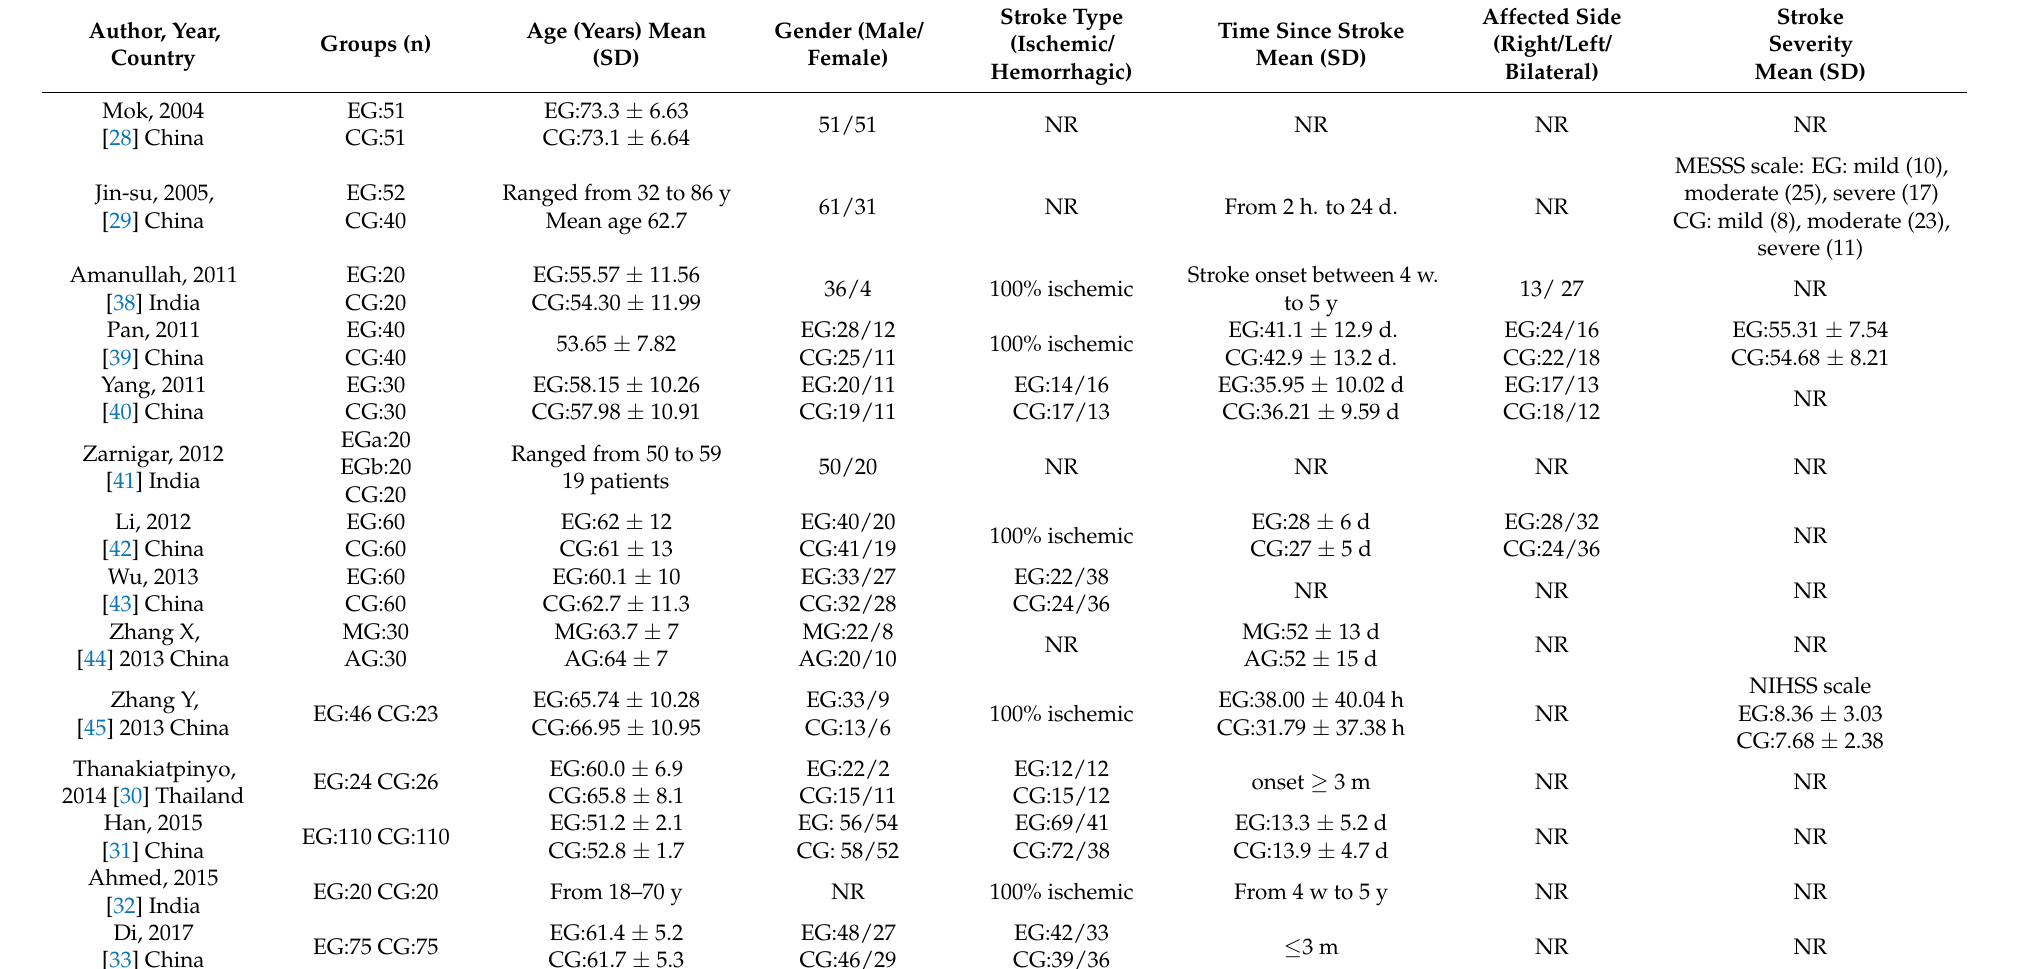
Table 1. General overview of selected studies and patient’s